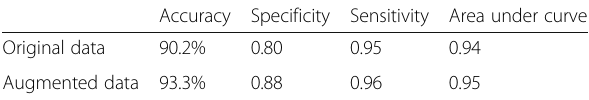
Table 3 Comparison summary of the convolutional neural network performance on original and augmented data